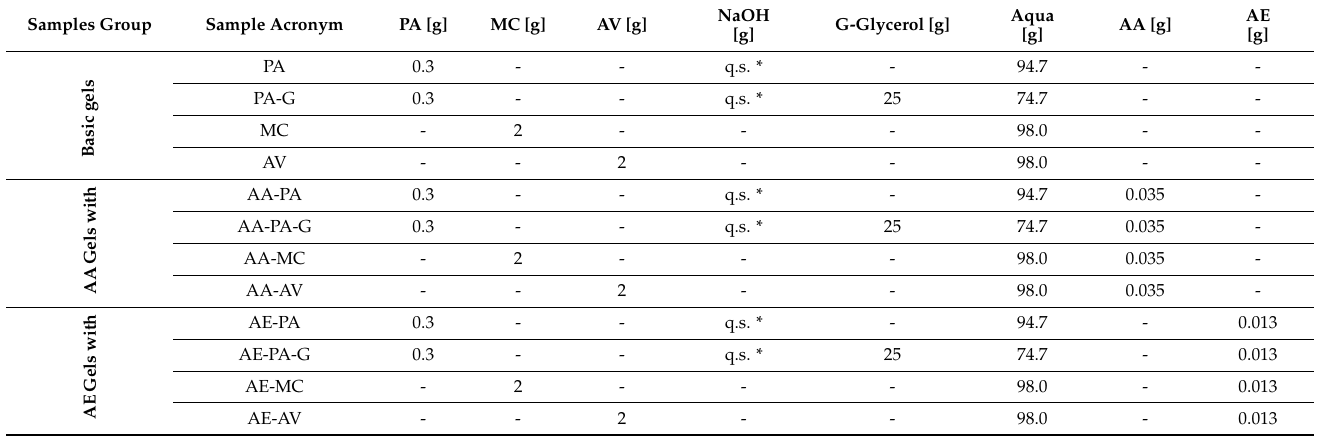
Table 6. Composition of evaluated polymeric gels.